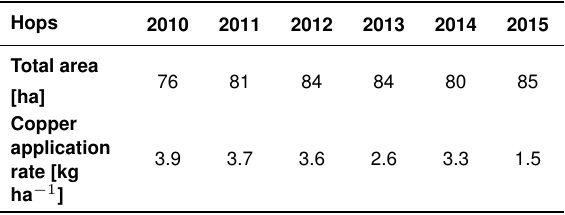
Table 6. Average copper application rates [pure copper kg ha − 1 ] in organic hop-growing in 2010 to 2015. Copper pesticides were applied to 100% of the hops area.